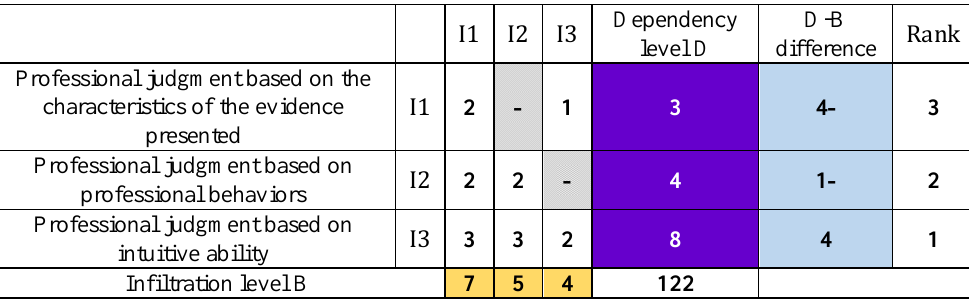
Table 10. ranks the level of dependence and influence of auditors'